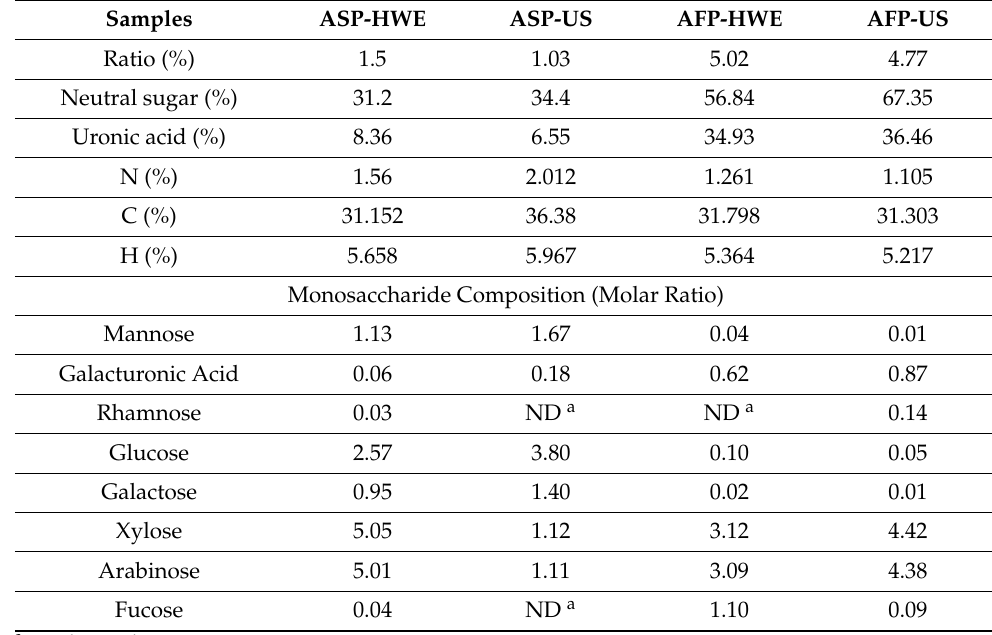
(Table 1). The amount of neutral sugar and uronic acid in the polysaccharides obtained by ultrasonic extraction was, respectively, 67.35% and 36.46% in Ajwa date flesh and 34.40% and 6.55% in Ajwa date seed (Table 1). Mrabet et al. studied 10 varieties of Tunisian dates and determined that they contain neutral sugar ranging from 15.56% to 25.71% and a low quantity of uronic acid that varies from 4.76% to 7.26 % [46]. Khatib et al. reported a percentage of 32.9% of galacturonic acids in the polysaccharide PF1 fraction extracted from Ajwa flesh [44], which is comparable to our results. Regarding the element analysis results, the amount of carbon, nitrogen, and hydrogen was comparable for the four polysaccharide samples as shown in Table 1. Table 1. Physicochemical characterization of polysaccharides extracted from Ajwa seed (ASP-HWE and ASP-Us) and flesh (AFP-US and AFP-HWE). Samples ASP-HWE ASP-US AFP-HWE AFP-US Ratio